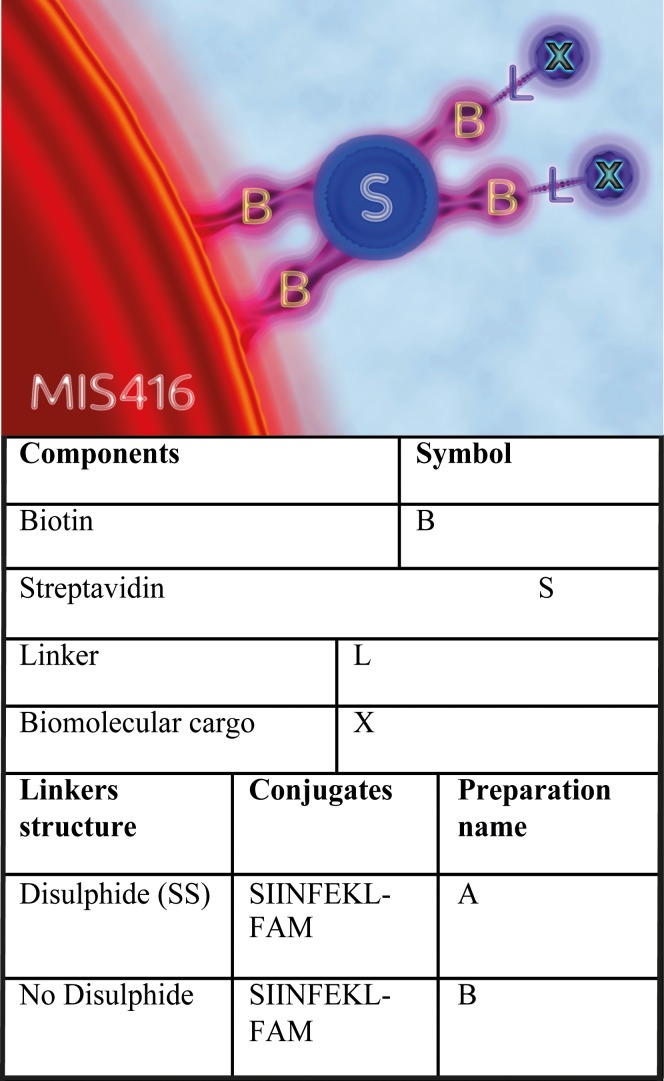
Coupling methodology.The conjugation strategy used to link MIS416 to biotinylated peptides and fluorophores. MIS416 was modified with the addition of biotin (B). Biomolecular cargos (X) were previously biotinylated and then conjugated to MIS416-biotin using streptavidin (S) as a bridge. The addition of a disulfide bond in the linking group (L) facilitates the release of the attached cargos in the cytoplasm of the target cells.